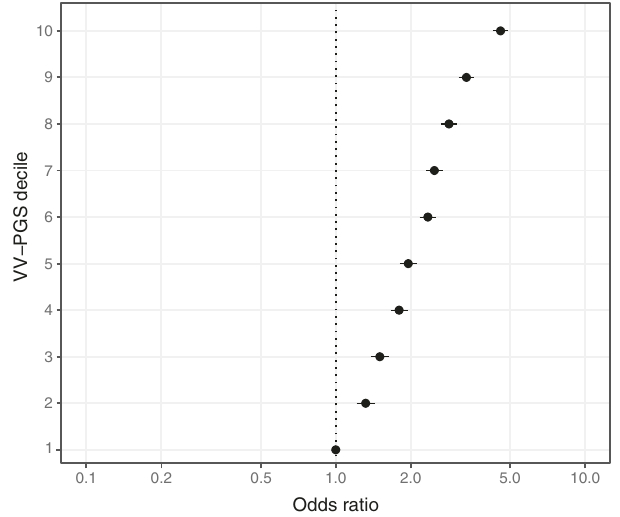
Fig. 3 Logistic regression for varicose vein case/control status in UK Biobank against VV-polygenic risk score (VV-PRS) decile. The VV-PRS was derived in an independent study sample, FinnGen ( n = 17,027 VV cases and 190,028 controls). Odds ratio refers to odds ratio of VV in UK Biobank versus decile 1 of VV-PRS (lowest). Error bars signify 95% con fi dence intervals of the odds